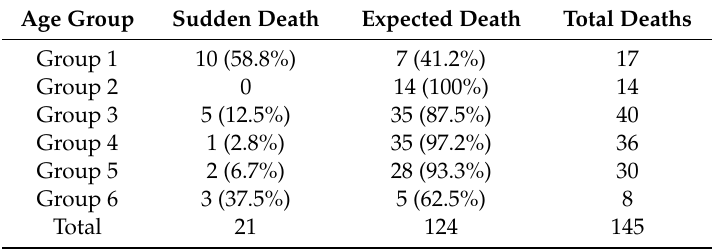
Table 1. Frequency and percentage of sudden and unexpected deaths, expected deaths and the frequency of total deaths stratified by age groups.